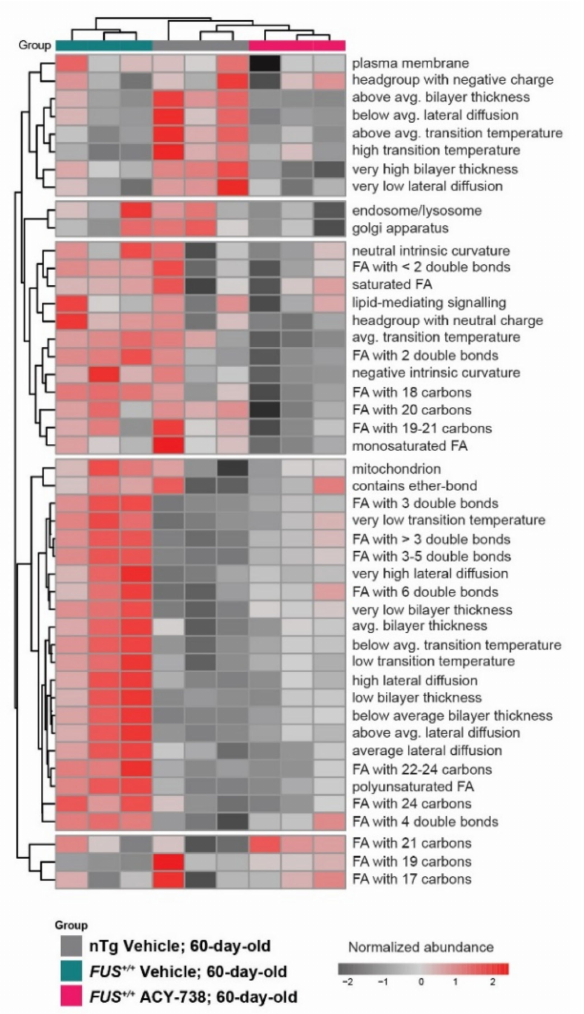
Figure 4. ACY-738 treatment partially reinstates enriched lipid ontology terms. Enrichment analysis of lipid ontology terms (LION) performed on normalized data. Each LION term represents a group of lipid species that share common properties. Heatmap representing clustered 60-day-old samples and color-coded enriched LION terms. Most significantly fluctuating LION terms for all the samples are displayed; red and gray colors indicate a high and a low enrichment. n = 3 per